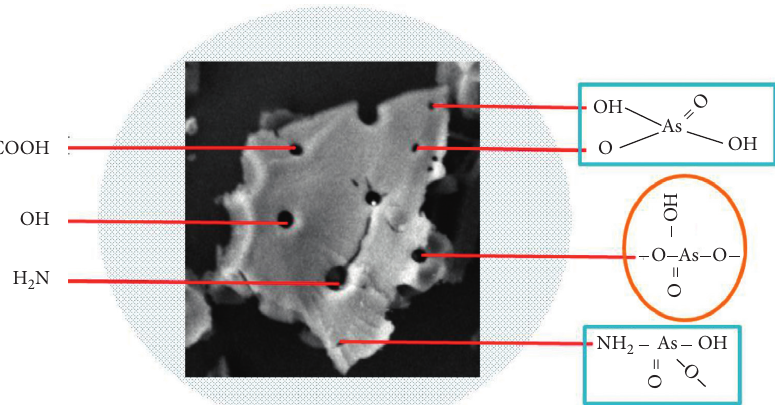
Figure 6: The proposed mechanism of As(V) adsorption by